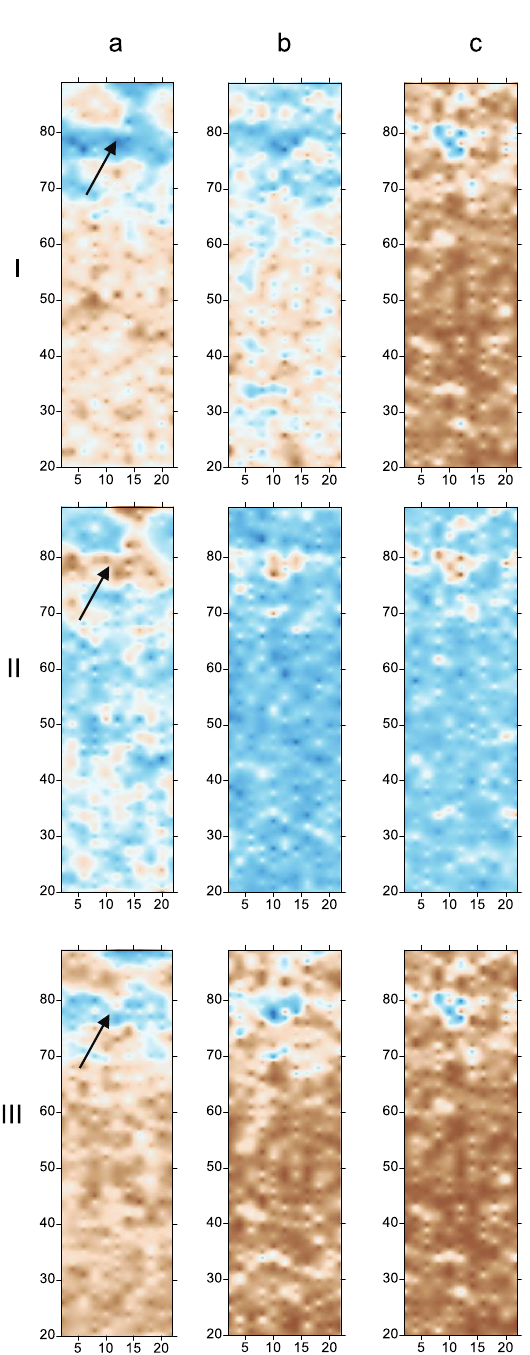
Figure 7. Column a-I : Raw GPR data at depth slice of 0.00–0.20 m below ground surface; a-II: Raw GPR data at depth slice of 0.20–0.40 m below ground surface; a-III : Raw GPR data at depth slice of 0.40–0.60 m below ground surface; b-I: Simulated GPR data at depth slice of 0.00–0.20 m below ground surface with 0.1 noise at spectral band and 0.1 noise at raw GPR data; b-II : Simulated GPR data at depth slice of 0.20–0.40 m below ground surface with 0.1 noise at spectral band and 0.1 noise at raw GPR data; b-III : Simulated GPR data at depth slice of 0.40–0.60 m below ground surface with 0.1 noise at spectral band and 0.1 noise at raw GPR data; c-I : Simulated GPR data at depth slice of 0.00–0.20 m below ground surface with 0.2 noise at spectral band and 0.1 noise at raw GPR data; c-II : Simulated GPR data at depth slice of 0.20–0.40 m below ground surface with 0.2 noise at spectral band and 0.1 noise at raw GPR data and c-III: Simulated GPR data at depth slice of 0.40–0.60 m below ground surface with 0.2 noise at spectral band and 0.1 noise at raw GPR